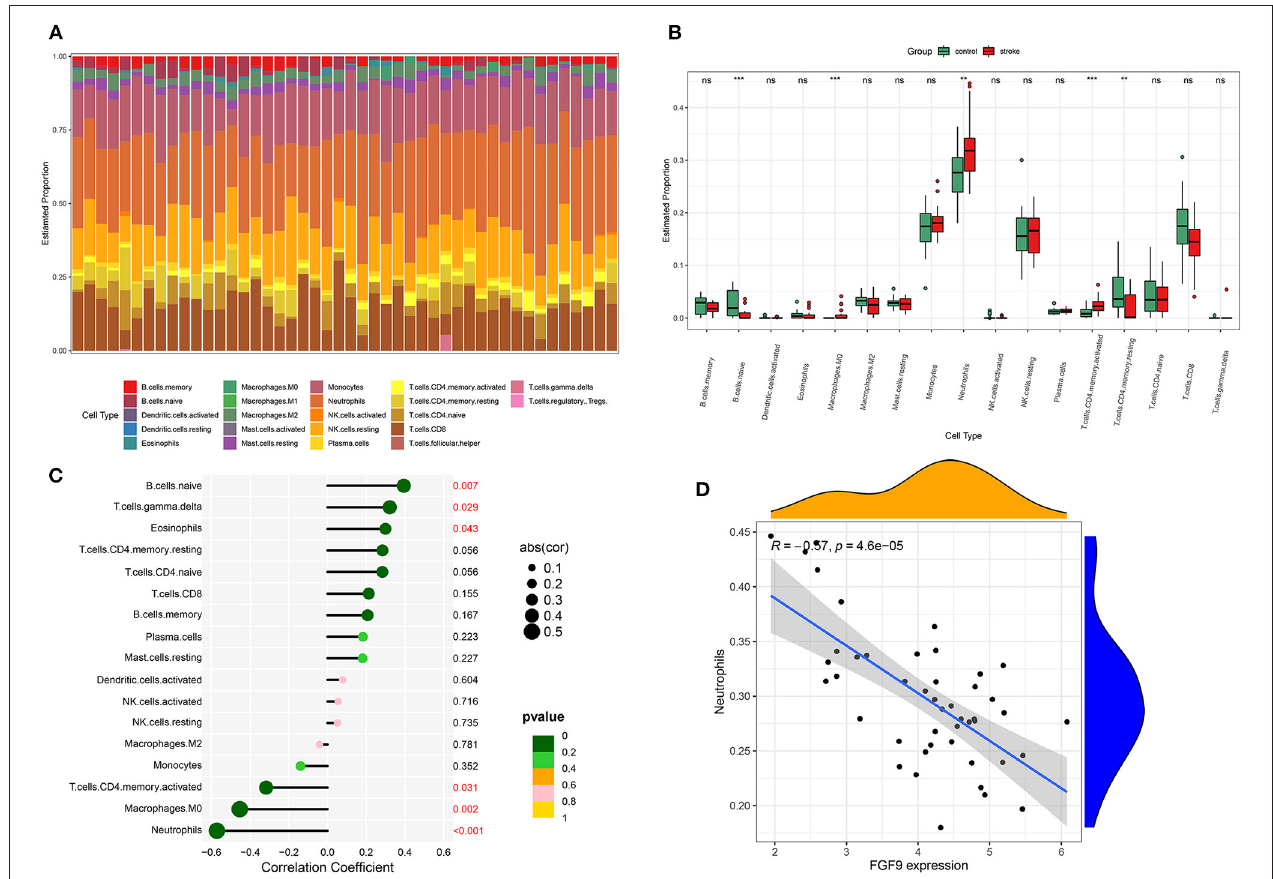
FIGURE 8 | Relative expression of immune cell subtypes. (A) Histogram of the proportion of each kind of immune cell. (B) Boxplot of relative expression of every immune cell subtypes between the controls and IS group. (C) Lollipop graph of the correlation between the FGF9 expression and each immune cell subtype. (D) The level of neutrophils was significantly negatively correlated with FGF9